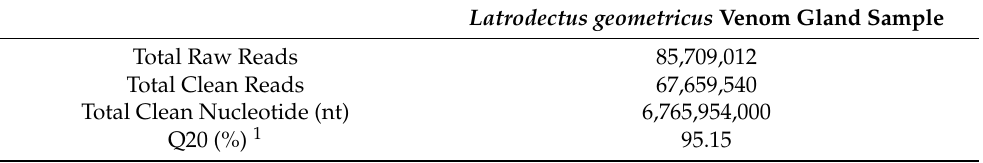
Table 1. Description of the output sequencing data.